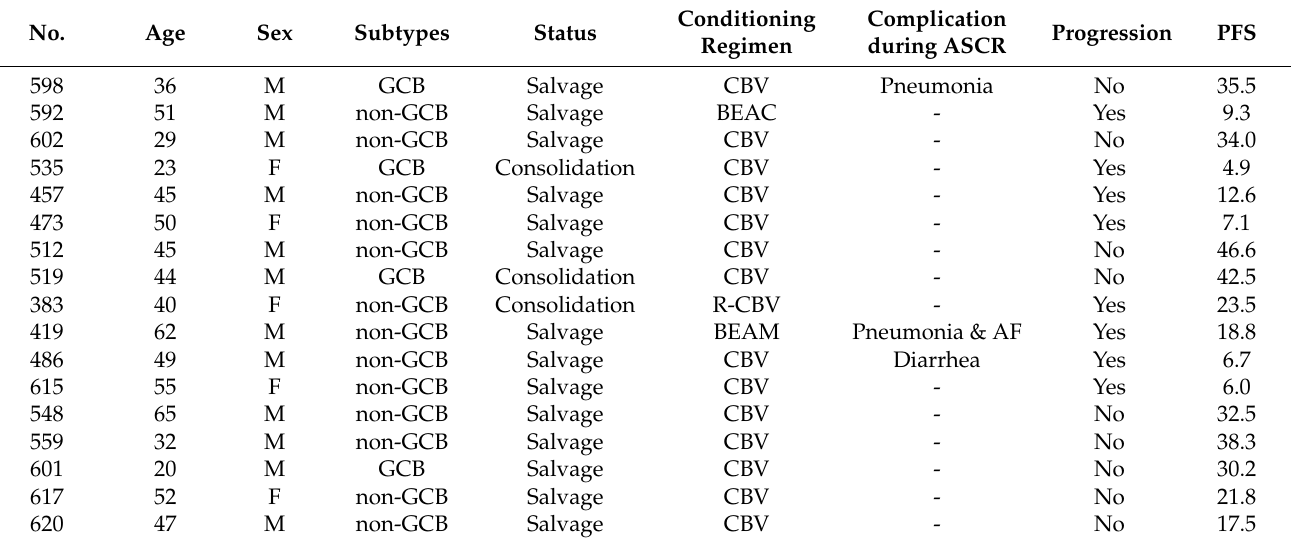
Table 1. Patients’ demographic background, treatment history, and clinical